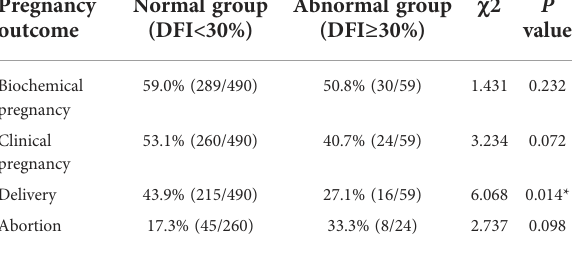
TABLE 3 Comparison of pregnancy outcome rates between the normal and abnormal sperm DFI group in fresh embryo transfer cycles. Pregnancy